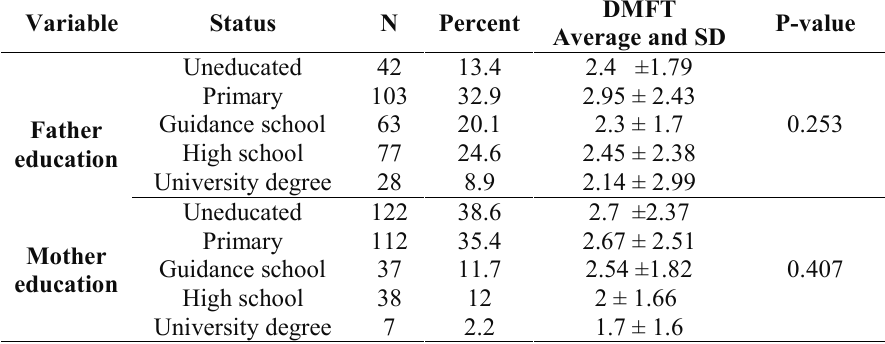
Table 6 Relationship between DMFT index with parents' education